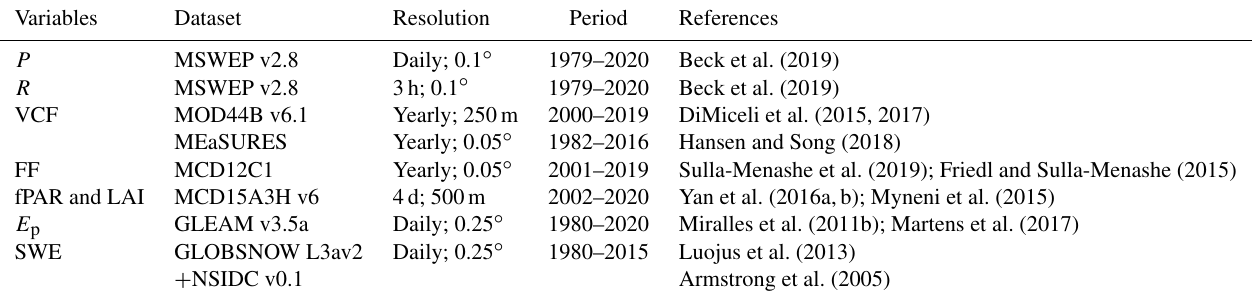
Table 1. Overview of the selected forcing datasets used in the global application of the vD–B model. Variables